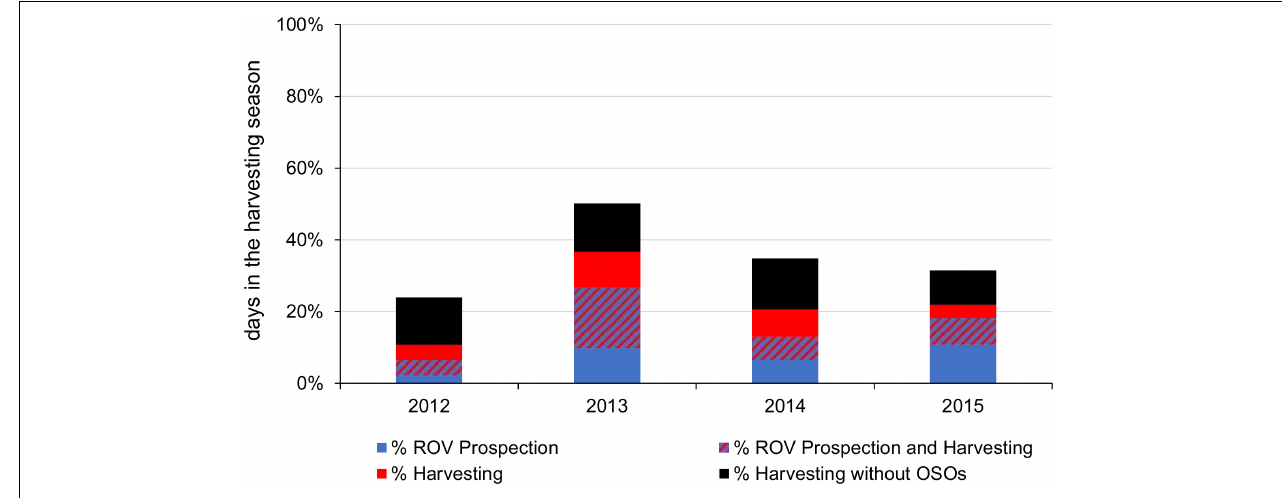
FIGURE 2 | Percentage of days in the harvesting season (2012–2015) dedicated to the different activities at sea.